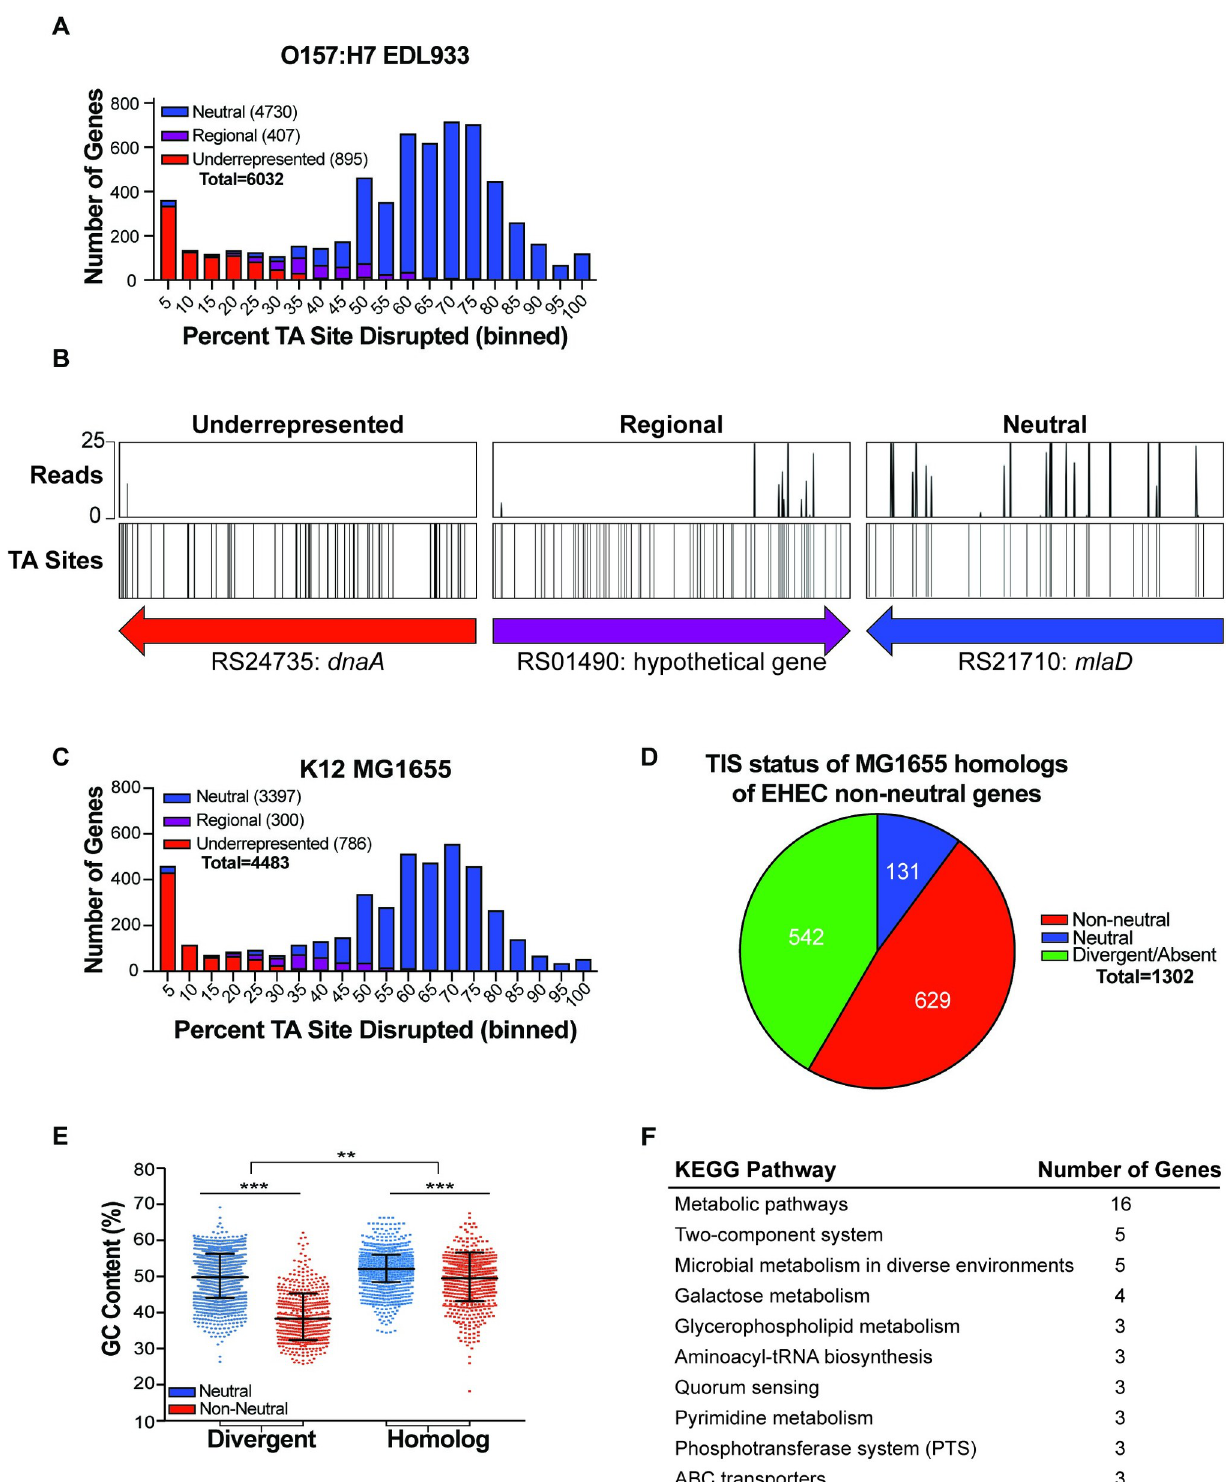
Fig 1. Analysis of essential genes in EHEC EDL933 and comparison to K-12 MG1655. (A) Distribution of percentage TA site disruption for all genes in EHEC EDL933. Genes are classified by EL-ARTIST as either underrepresented (red), regional (purple), or neutral (blue). (B) Transposon-insertion profiles of representative underrepresented, regional, and neutral genes. (C) Distribution of percentage TA site disruption for all genes in K-12 MG1655. Genes are classified by EL-ARTIST as underrepresented (red), regional (purple), or neutral (blue) using the same parameters as for the EDL933 library.